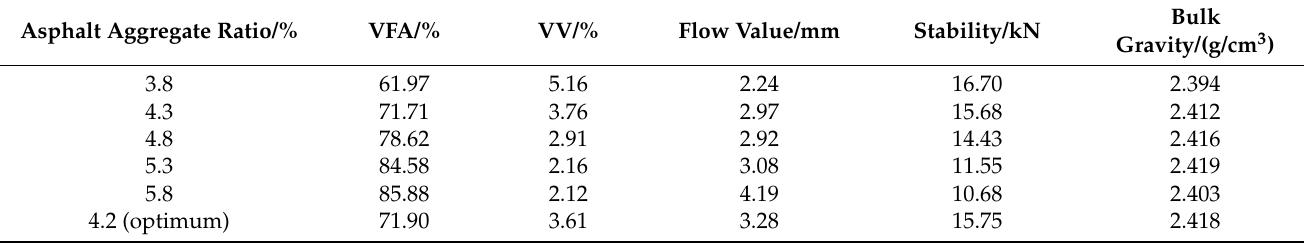
Table 7. Marshall test